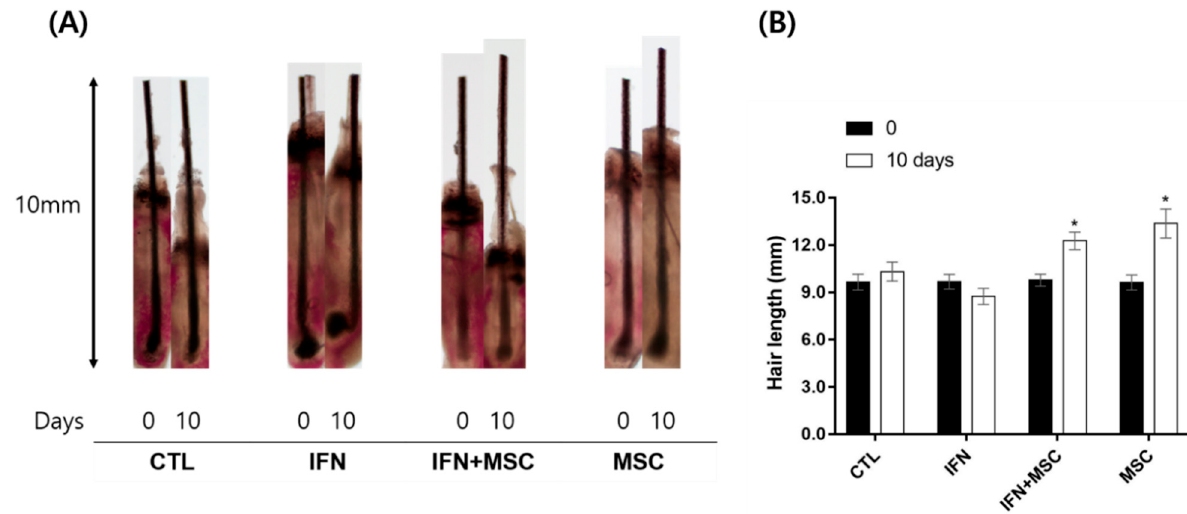
Figure 9. Mouse vibrissae organ culture. ( A ) HF and hair shaft morphology during the 10-day experimental period. ( B ) Hair length of hair shafts of 0 and 10 days. MSCT stimulates hair shaft and HFs in organ culture. A total of 80 mouse vibrissae were obtained and treated for 10 days with IFN- γ (100 ng/mL), MSCT, or both IFN- γ and MSCT. The length of each HF was measured under a microscope on days 0 and 10. The relative length of each hair shaft is shown as mean ± SEM (upper panel). Error bars represent the mean ± SEM, n = 5. * p < 0.05 compared with the 0 day.